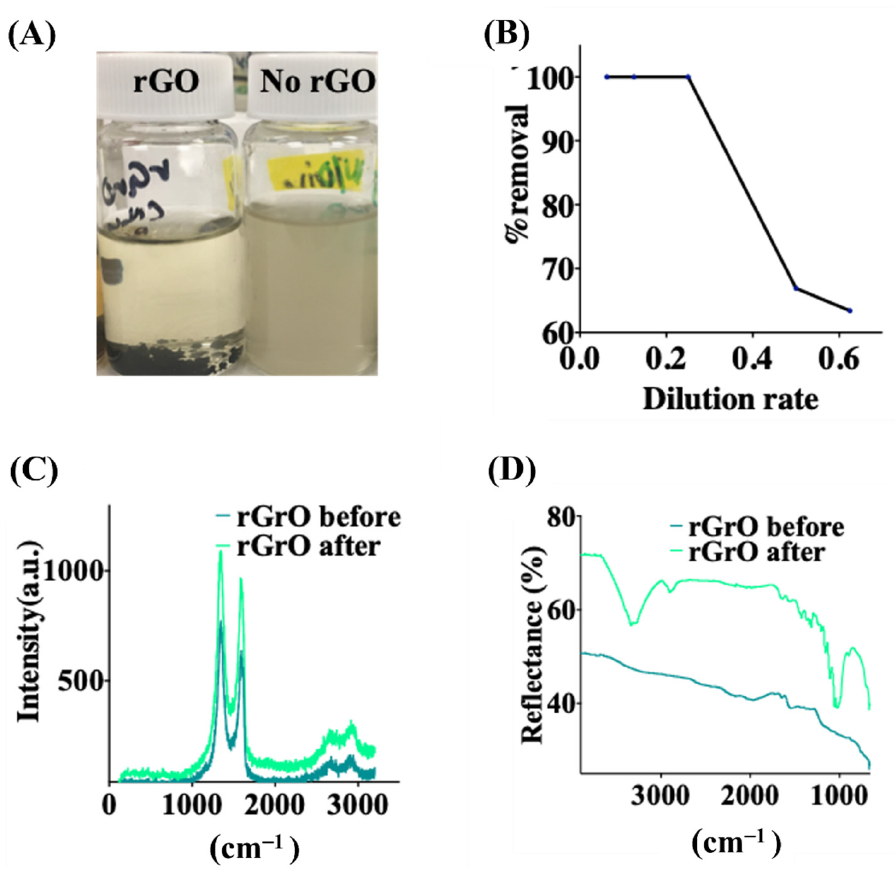
Figure 4. Treatment of wastewater from photo-processing operations (WPO) using rGO. ( A ) Photos for the treatment of WPO sample with rGO after 48 h and a control sample without rGO. ( B ) Percentage of adsorption (Removal%) of chemical compounds from WPO by rGO. ( C ) Raman analysis of rGO before and after adsorption, showing that the basal structure of graphene material remains intact. ( D ) FT-IR spectra of rGO before and after treatment of WPO, showing how a significant number of groups bind to graphene, indicating adsorption by rGO.